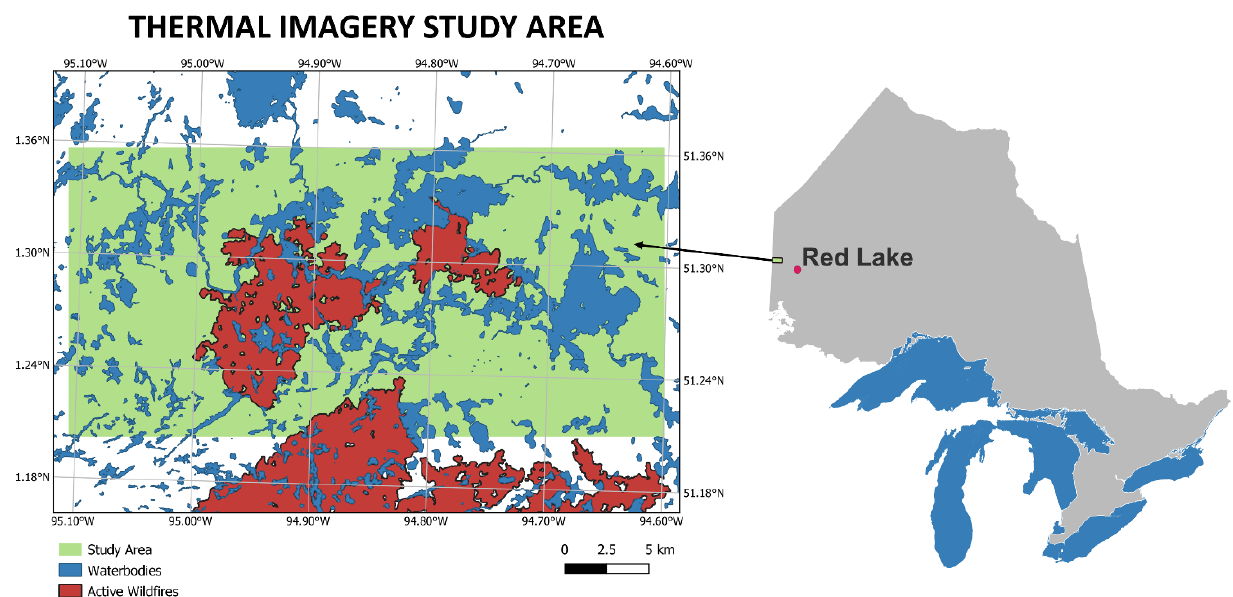
Figure 1. Thermal imagery study area in Woodland Caribou Provincial Park, near Red Lake Ontario. Map displays the wildfires that were active at the time of image collection, on 12 August 2018, based on the National Burned Area Composite (NBAC) of Canada [35].